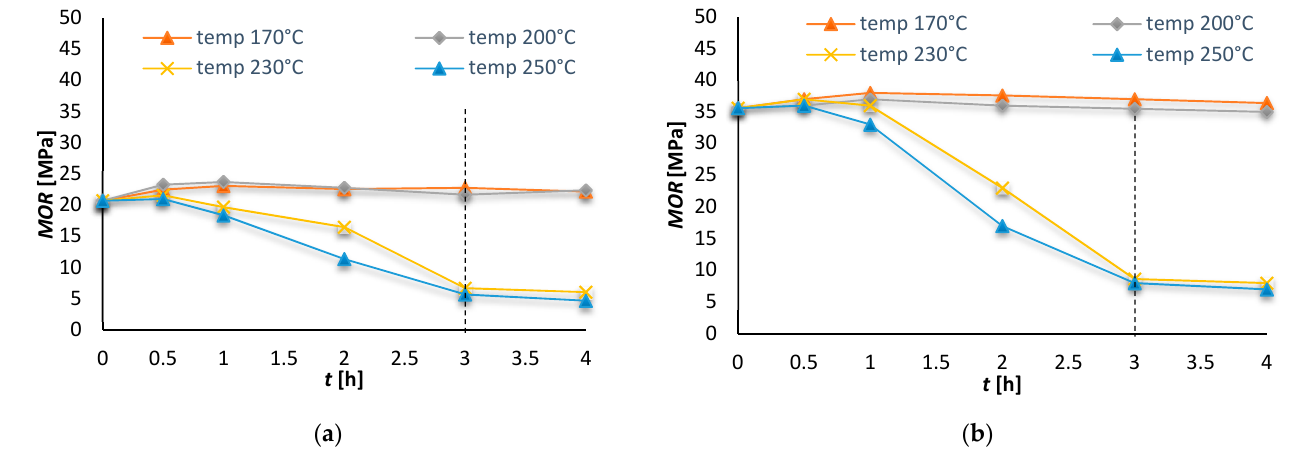
Figure 1. MOR of samples exposed to high temperature over time of 0.5 – 4 h: ( a ) series A, ( b ) series C.